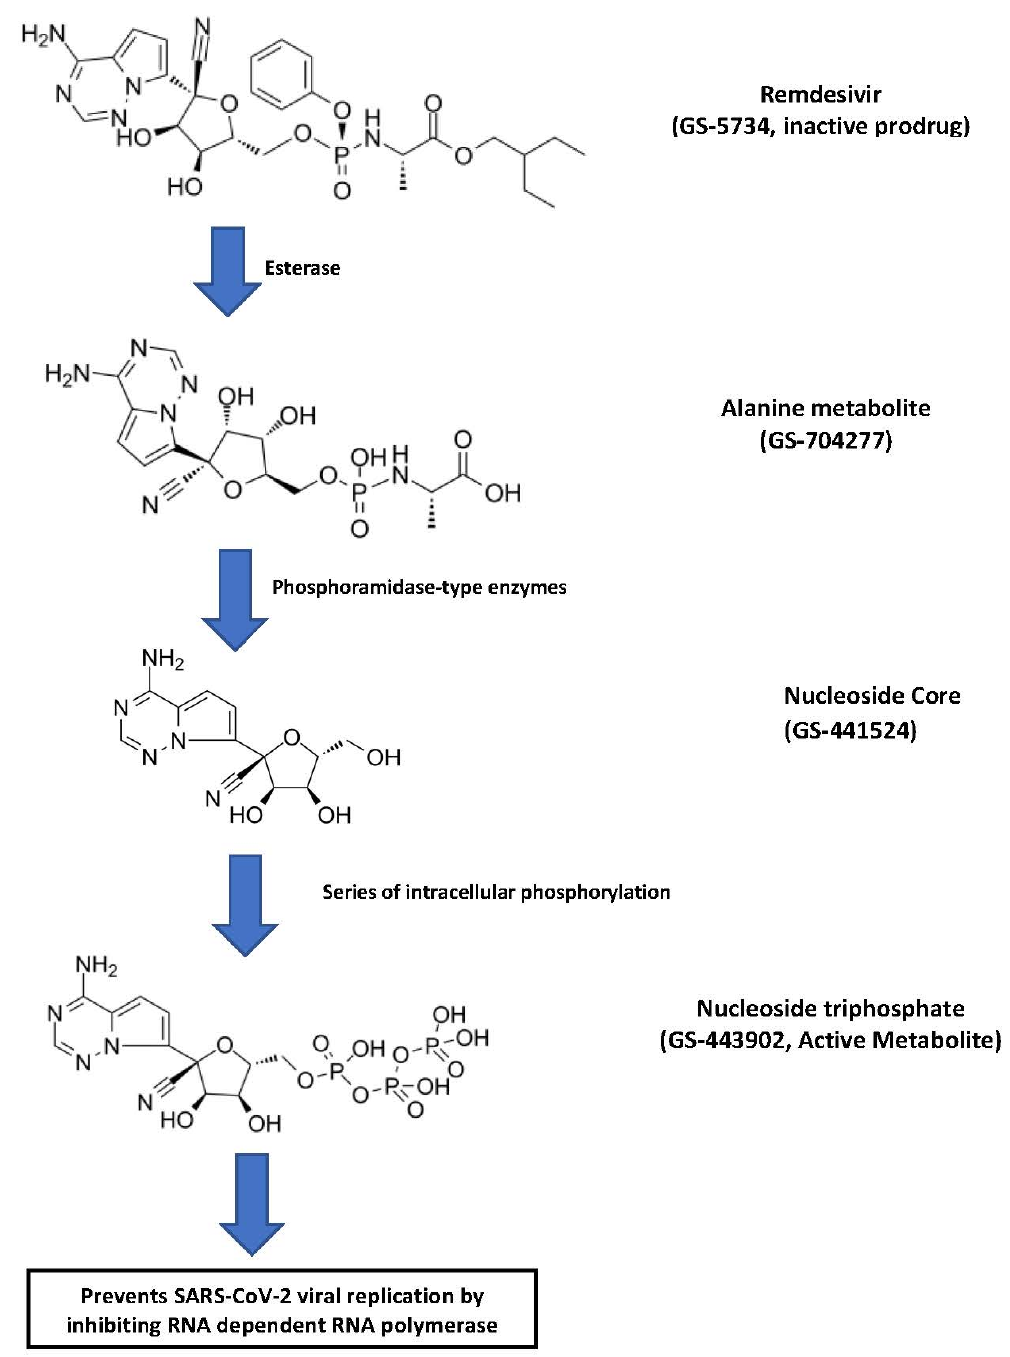
Figure 1. Step-wise bioactivation of remdesivir [15,18] .